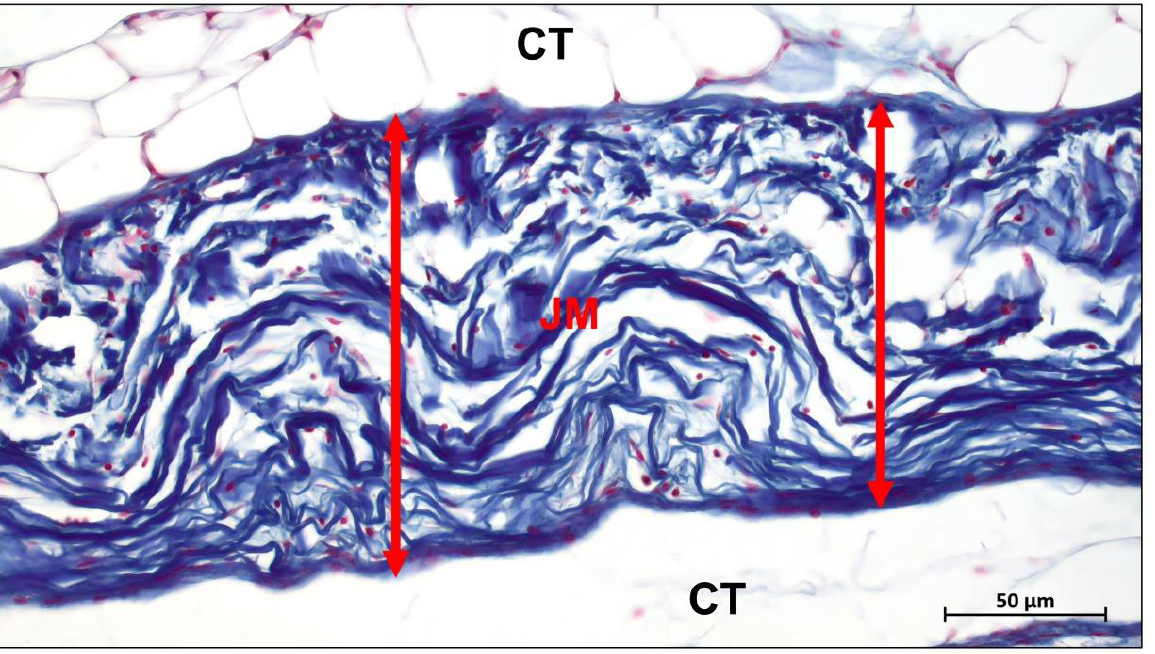
Figure 3. Representative histological image showing the tissue reaction and integration pattern of the pericardium-based barrier membrane Jason (JM, double arrows) within the subcutaneous connective tissue (CT) at day 120 post implantationem (Masson Trichrome staining, 200× magnification, scalebar = 50 µm).